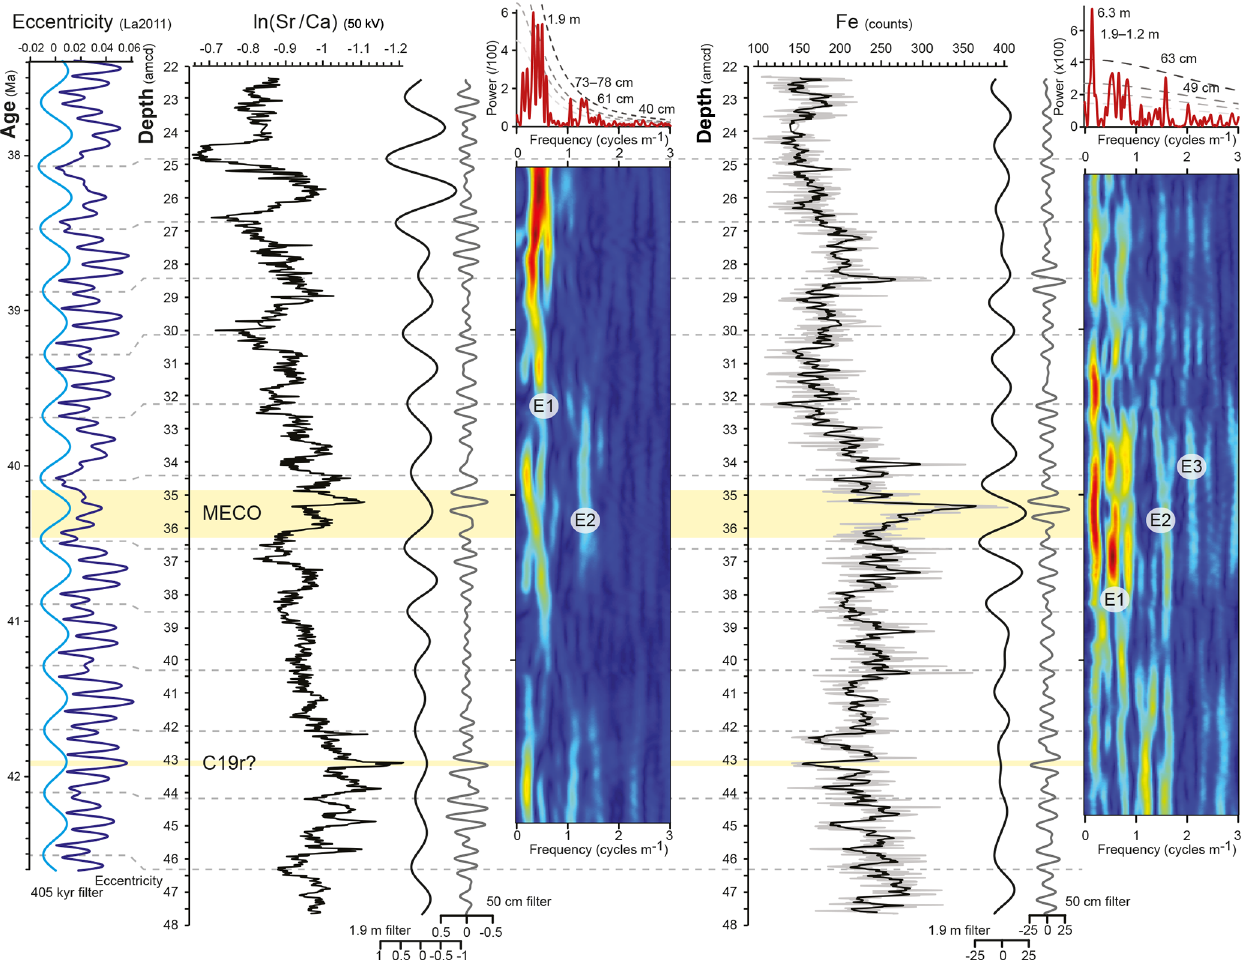
Figure 3. Time series analyses of the ln(Sr / Ca) and Fe intensity data and preliminary orbital tuning. From left to right: the La2011 eccen- tricity solution (dark blue) and its 405kyr bandpass filter (light blue) and the ln(Sr / Ca) record and the Fe intensity record, flanked by their 1.9m (black) and 50cm (grey) bandpass filters and evolutive power spectra, with E1, E2, and E3 indicating the potential imprint of the 405, 125, and 95kyr components of eccentricity, respectively. The evolutive spectra are topped by Redfit power spectra with dashed lines showing the 99%, 95%, 90%, and 80% confidence levels and with main periodicities indicated. Horizontal yellow bands indicate the position of the MECO and the C19r event. Horizontal grey dashed lines indicate tentative tuning tie points between the ln(Sr / Ca) bandpass filter and the astronomical